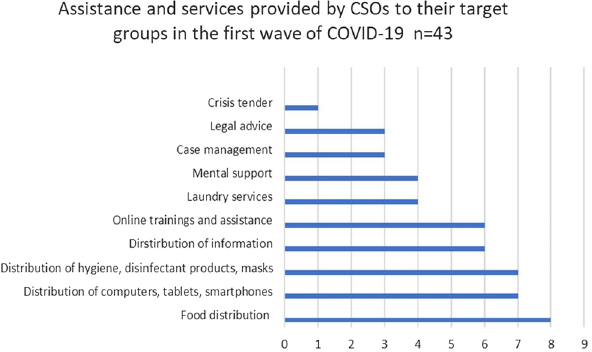
Figure 7: Organizations ’ assistance and services to their target group in the first wave of